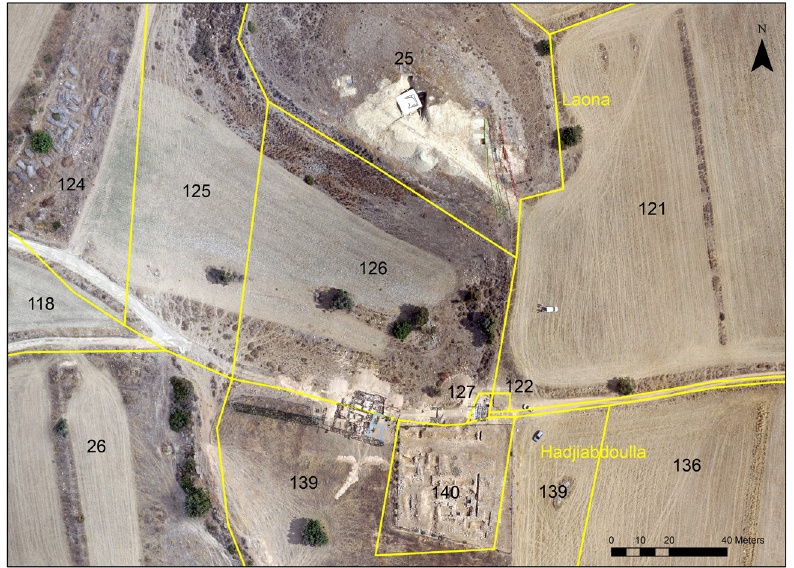
Figure 18. The Hadjiabdoulla East (Palace) and West Complexes and the Laona mound. Cadastral map with aerial orthophoto background. Drafted by A. Agapiou